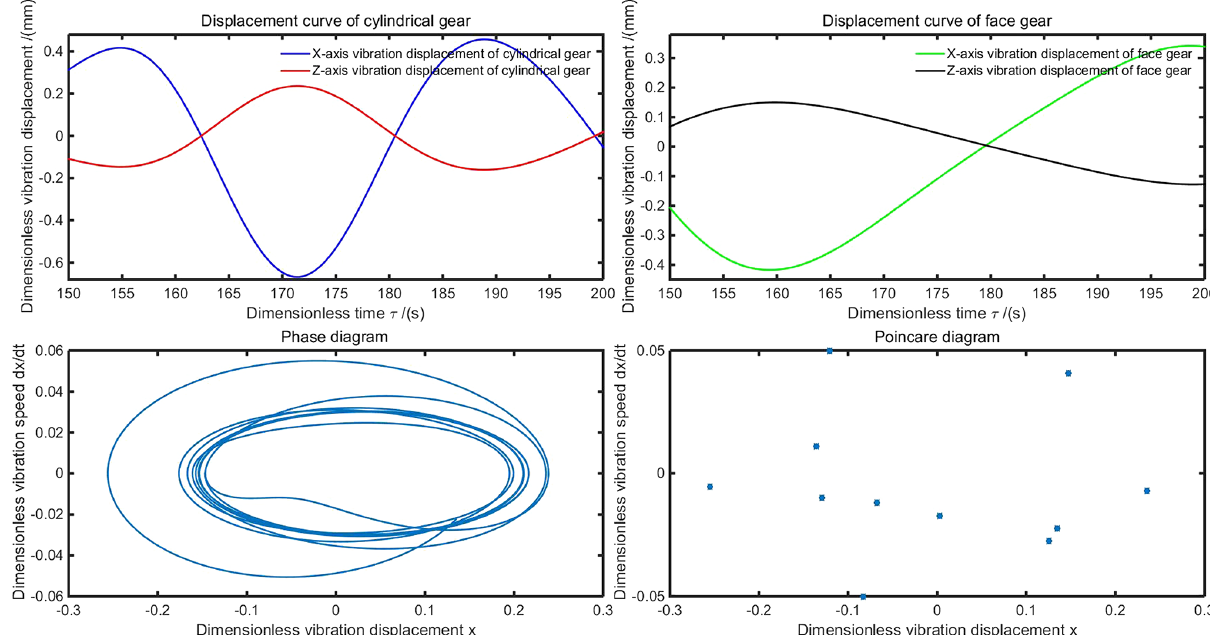
Figure 19. Displacement, phase, and Poincare diagrams of nonlinear system with transmission error fluctuation value